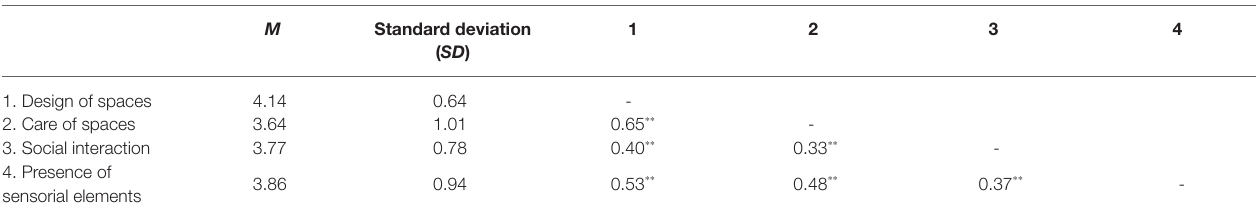
TABLE 5 | Descriptive statistics and correlations of predictor variables for parks.